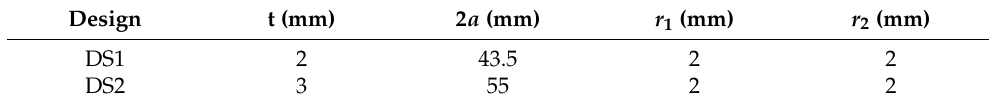
Table 6. Summary of the geometrical parameters of the optimal design solutions.